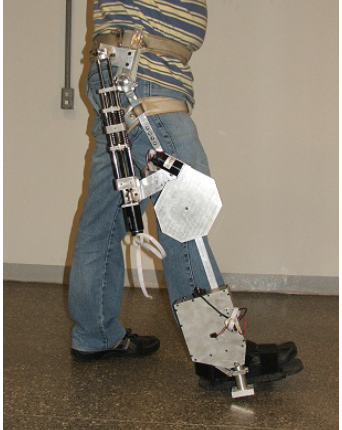
Figure 1. The end of the swing phase of a step through the